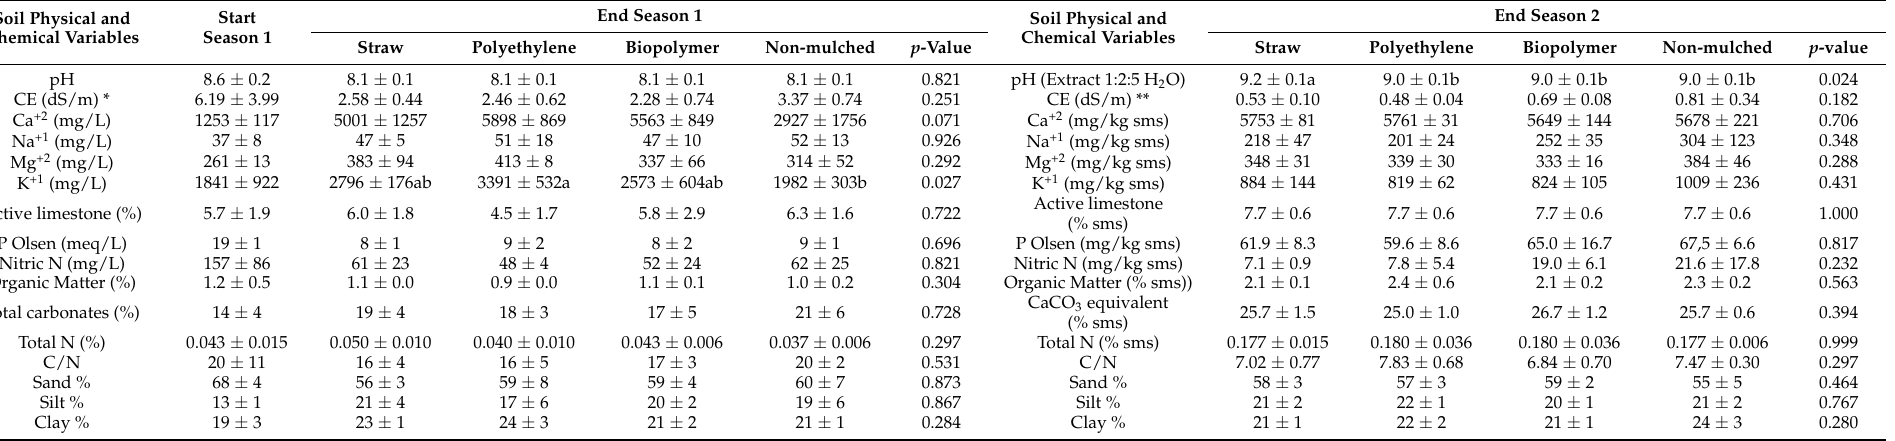
Table 1. Soil physical and chemical variables at the beginning of the study (start of season 1), and at the end of the two crop seasons, depending on the mulches and for the non-mulched